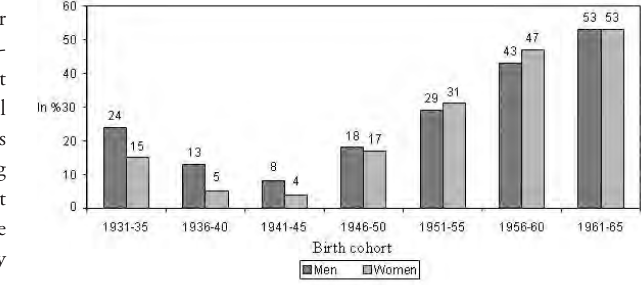
Figure 3: Occurrence of unemployment under the age of 30, 9 sorted by cohorts, West Germany.